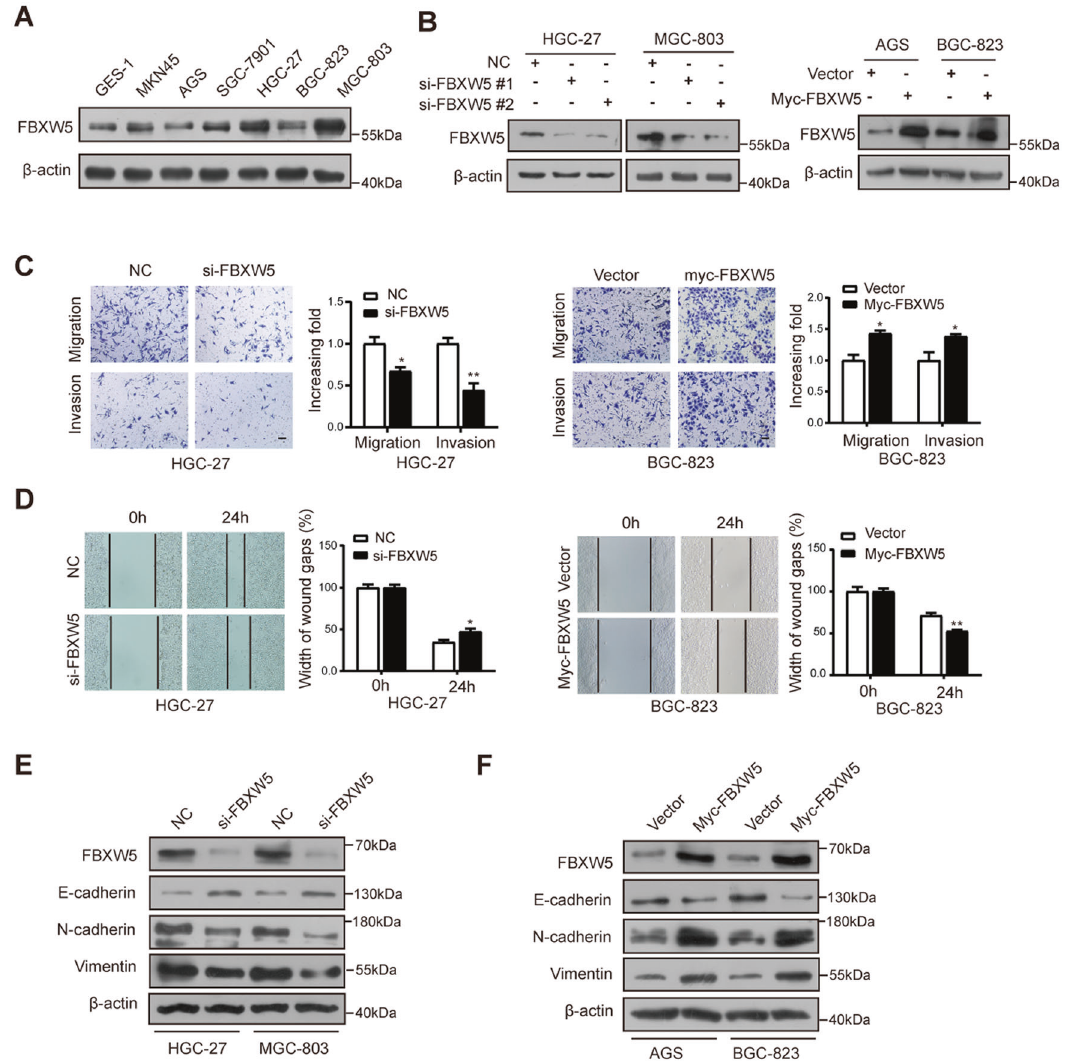
Fig. 2 FBXW5 promotes the invasion, migration, and EMT of GC cells. A Analysis of FBXW5 level in the GC cell lines. B Veri fi cation of the transfection ef fi ciency. C , D After the upregulation or silencing of FBXW5 in GC cells, transwell and wound healing assays were conducted. E , F Effects of the upregulation or silencing of FBXW5 on the EMT protein. * P < 0.05, ** P < 0.01. Bar scale: 100 μ m. Data were presented as mean ± SEM from three biologically independent